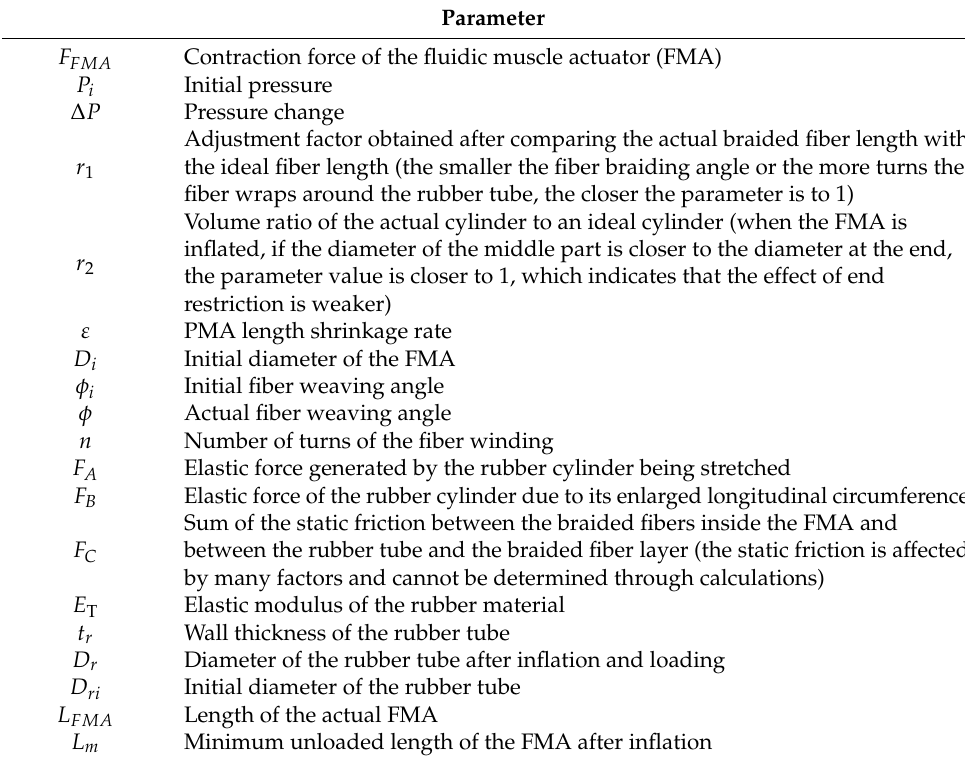
Table 2. Parameters used in the system